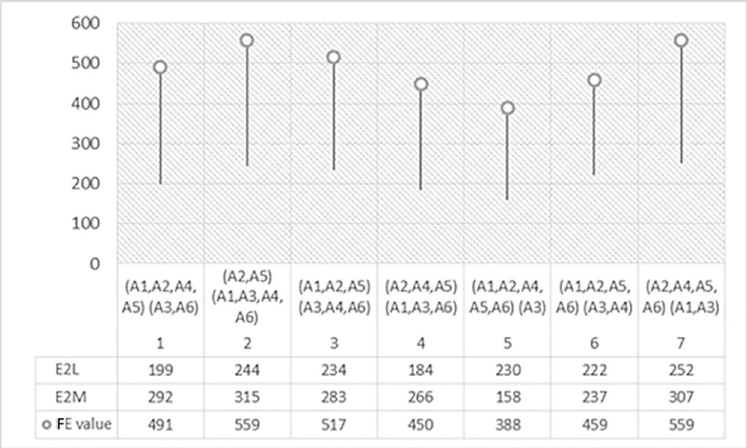
Figure 3. Partitioning schemes.